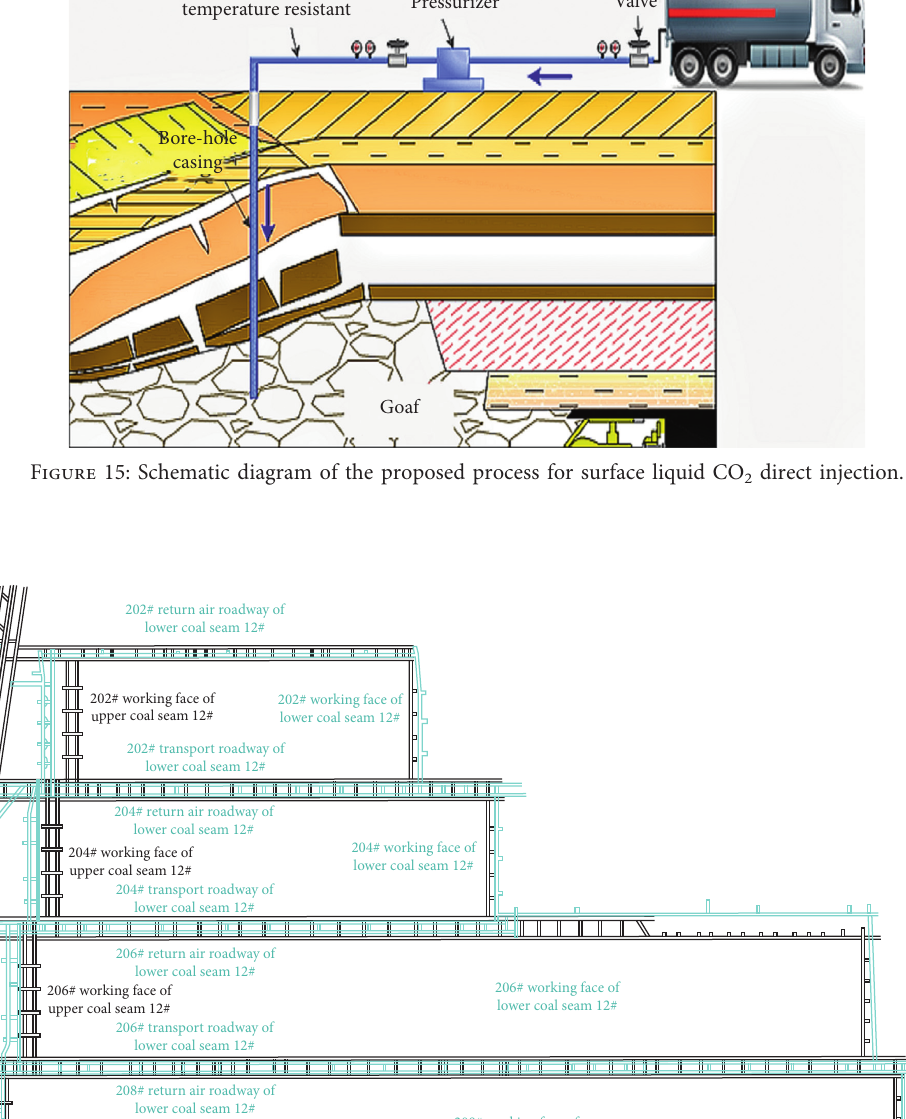
Figure 16: Layout of 206# working face of 12# lower coal